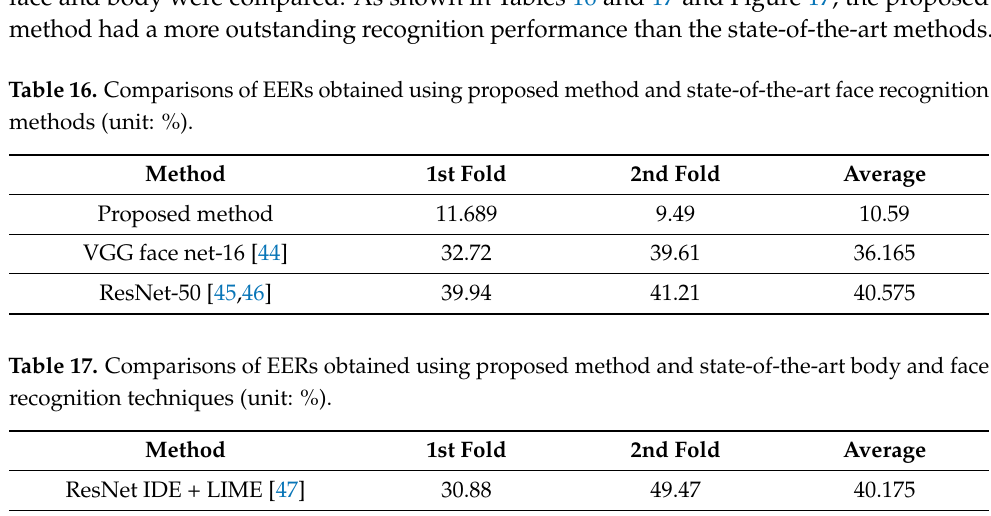
Figure 16. ROC curves acquired by our proposed method and previous GAN-based methods. ( a , b ) Recognition results for face and body images, and ( c ) score-level fusion result. Table 15. Comparisons of EERs obtained using our proposed method with those obtained using state-of-the-art GAN- based methods (unit: %).